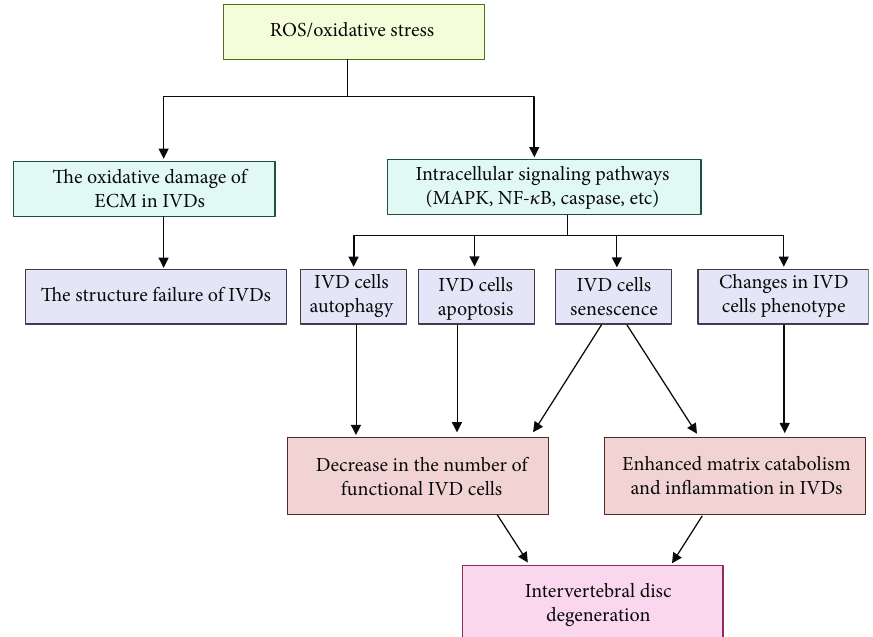
Figure 6: The role of ROS/oxidative stress in the development of